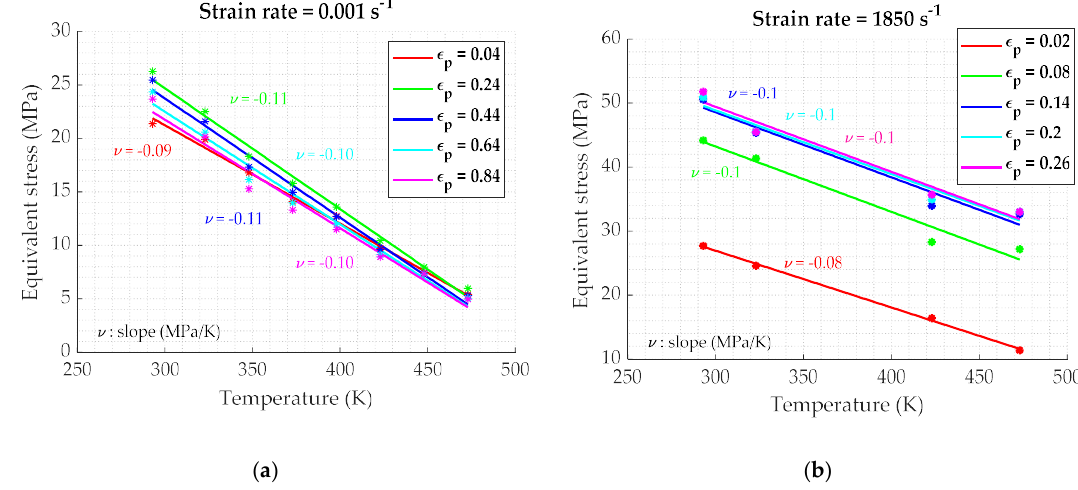
Figure 18. Temperature–stress for different strains: ( a ) in quasi-static conditions; ( b ) in dynamic conditions.